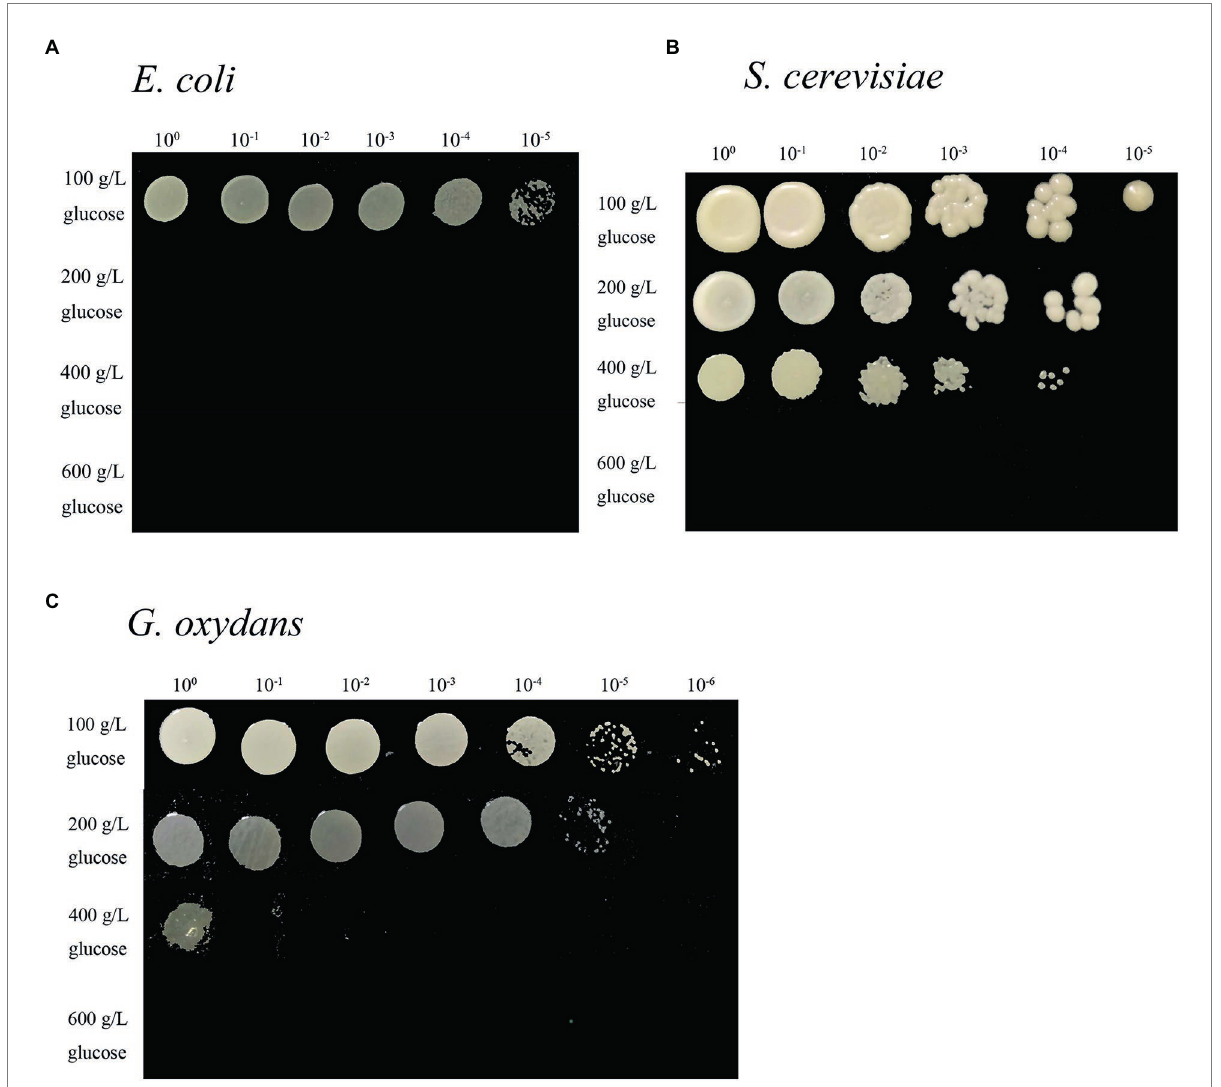
FIGURE 1 Spot assays of the E. coli (A) grown on LB medium, S. cerevisiae grown on YPG medium (B) , and G. oxydans (C) grown on YS medium at different glucose